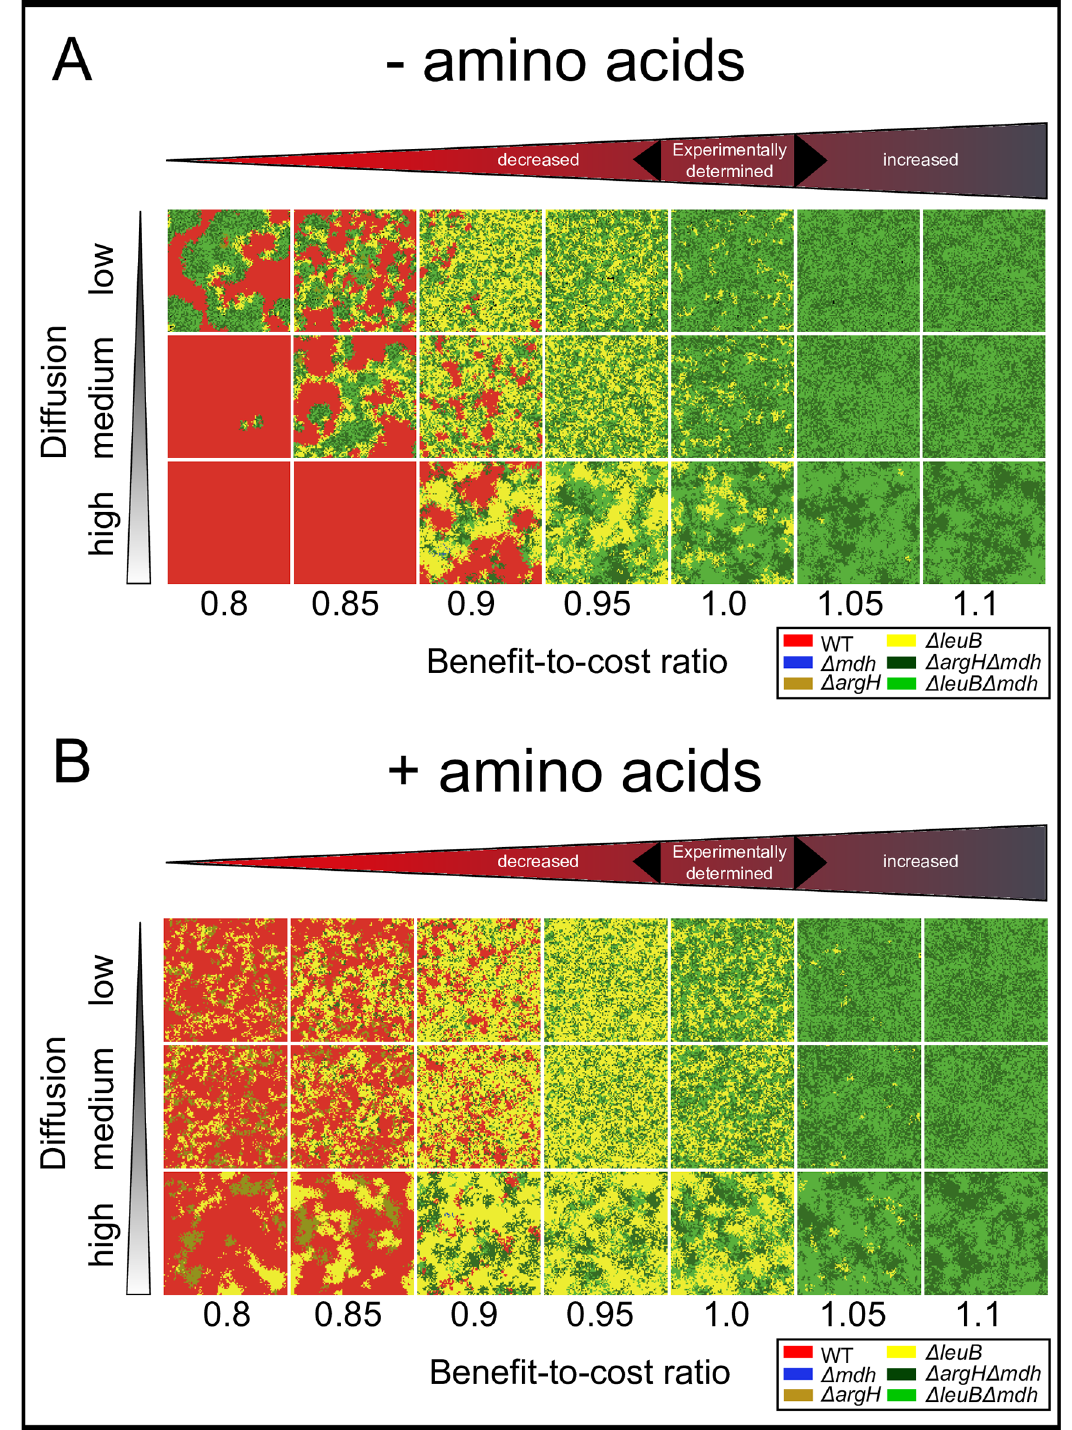
Fig 2. Auxotrophic and cross-feeding genotypes are selectively favored under a broad range of conditions. Shown are representative simulation results after 100 simulation steps. Parameters analyzed include the benefit-to-cost ratio where the experimentally determined values were computationally in- or decreased (x-axes), the degree of metabolite diffusion in the environment (y-axes) ranging from low (structured environment) to high (unstructured environment), and the environmental availability of amino acids ( A,B ) including ( A ) no amino acids are available in